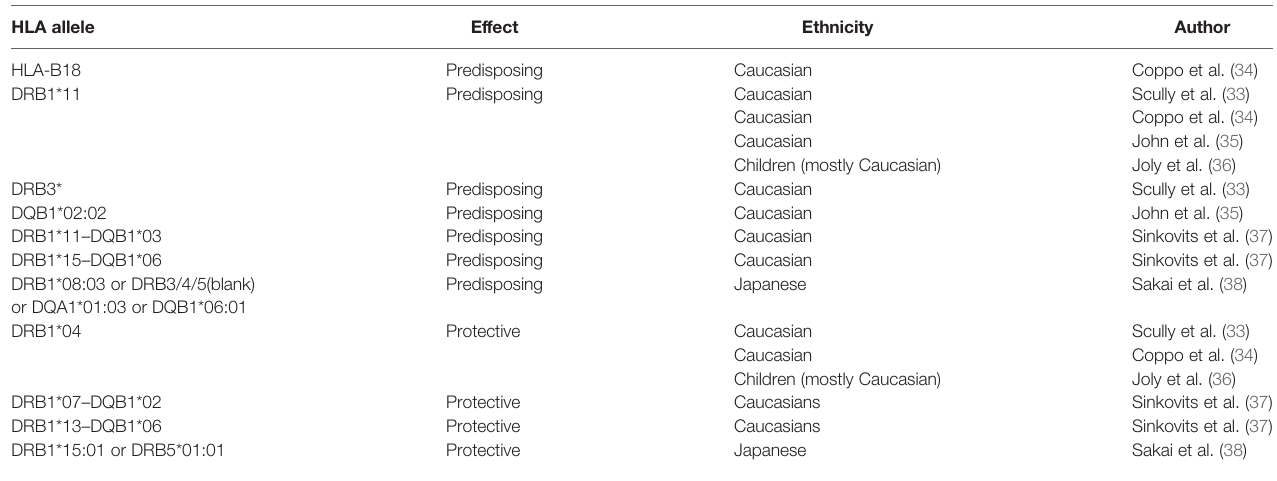
TABLE 1 | HLA associations reported for